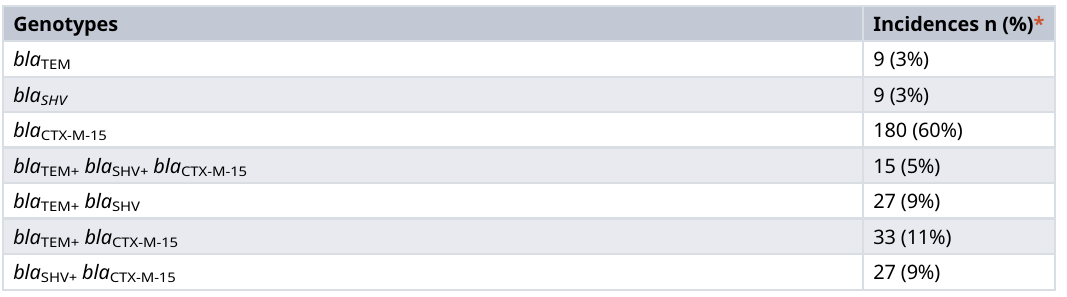
Table 5. Prevalence of ESBL genotypes.